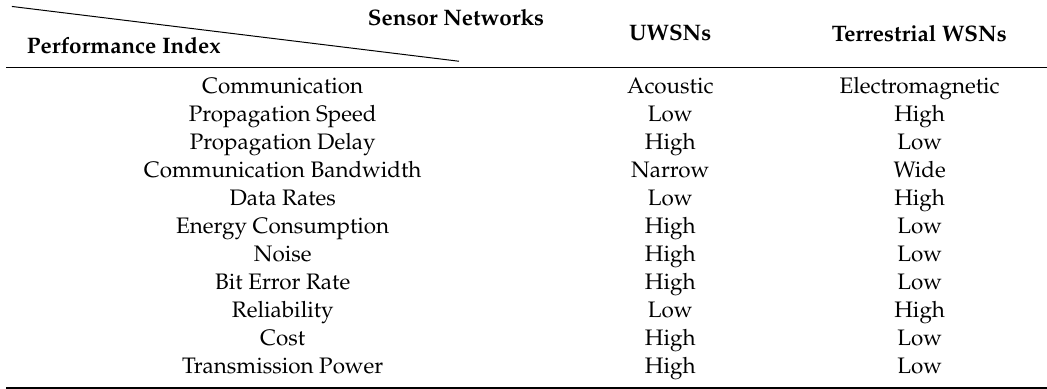
Table 1. Comparison between underwater wireless sensor networks (UWSNs) and terrestrial wireless sensor networks